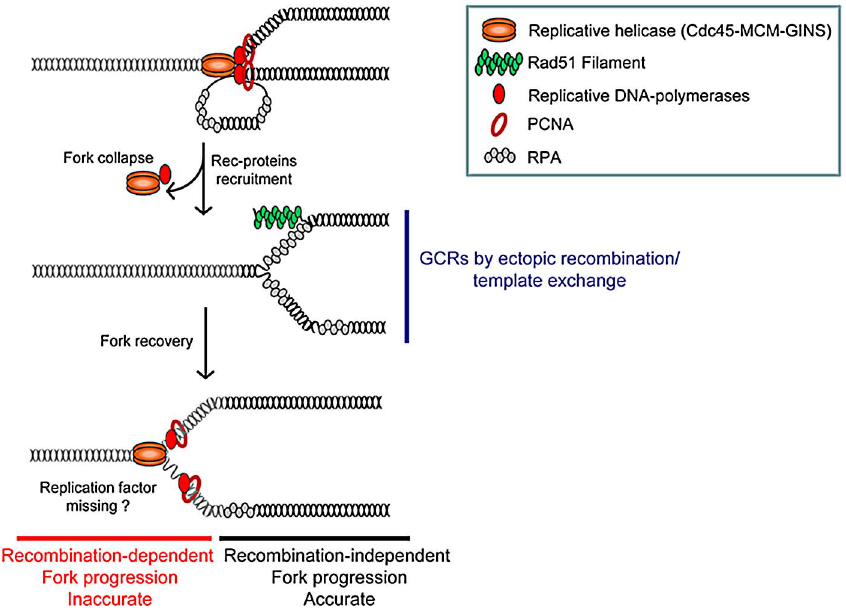
Figure 6. Model of replication-stress-induced genetic instability at collapsed forks. Collapsed forks might arise from torsional stress, fork breakage ( i.e. at nick, ICLs), or proteins tightly-bound to DNA. Replisome disassembly at collapsed forks may favour the unwinding of the nascent strand on which Rad51 nucleates. At this initial stage of fork resumption by recombination, homology-driven template exchange can promote intra- or inter-recombination resulting in GCRs. Fork recovery by recombination overcomes the initial replication block and allows an inaccurate replisome to form (see text for details).